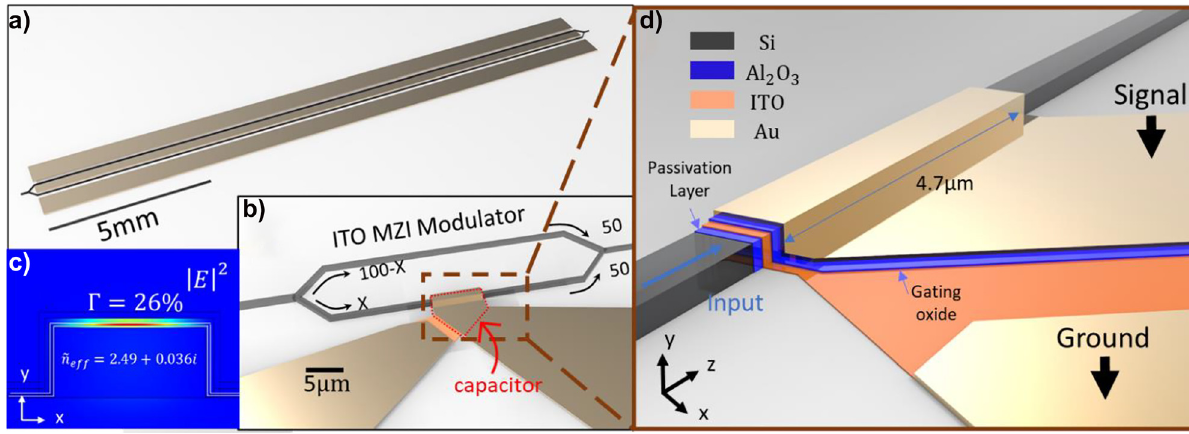
Figure 1: ITO-based plasmonic MZI modulator on Si photonic platform. (a) Footprint comparison between ITO MZI modulator and traditional MZImodulator.TheITO-basedplasmonicMZImodulatorwithinputandoutputgratingcouplersis1mmlongand165µminwidth,includingthe contact pads. The size of ITO-based plasmonic MZI is 33 µm in length and 6 µm in width. The distance between the grating coupler and the device is longer than 500 µm to facilitate measurement. (b) Perspective view of the Mach – Zehnder structure with the active biasing contacts. The power splitting ratio for the active arm is X , and the splitting ratio for the passive arm is 100- X . (c) Electric fi eld distribution by performing FEMat1550nmunder + 3.5Vinthecross-sectionalstructurefora z cutlinealongthecentralregionoftheSiwaveguide(width:500nm;height: